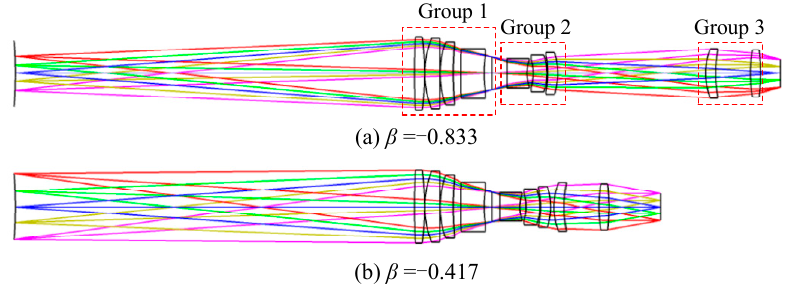
Figure 13. Configuration diagrams of the zoom relay imaging group. ( a ) magnification β = − 0.833, ( b ) magnification β = − 0.417.